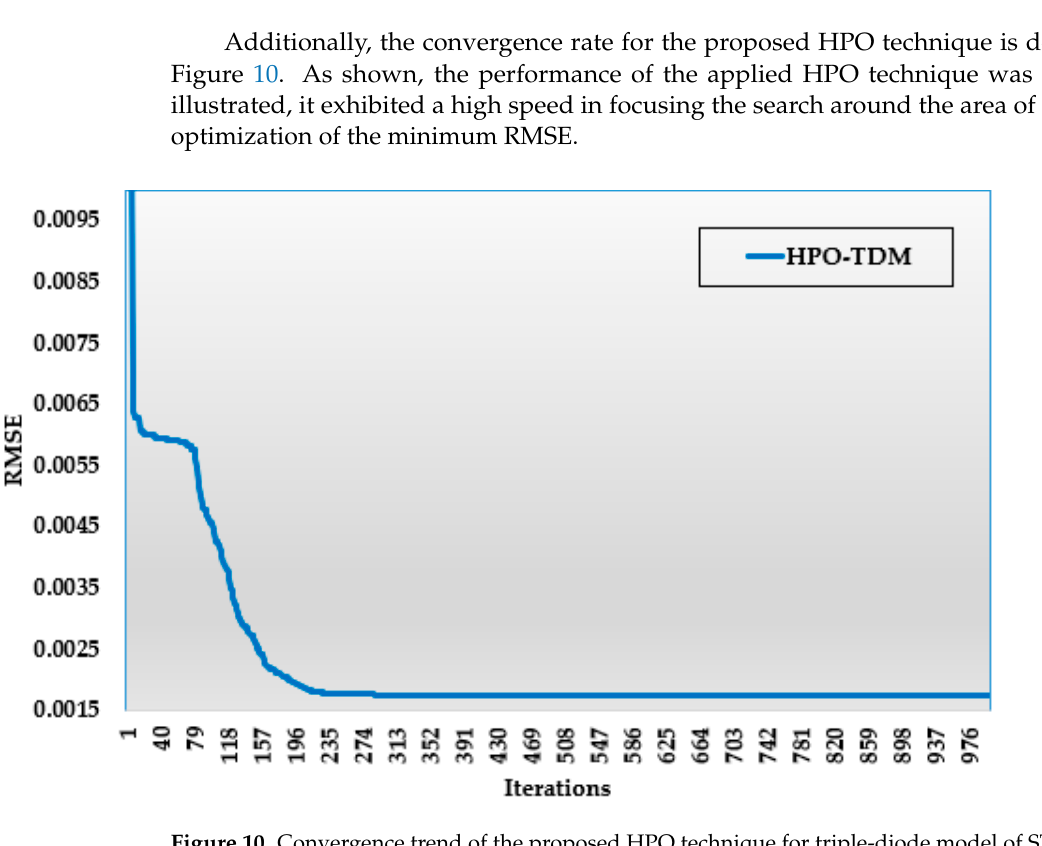
Table 7. Comparative assessment of the proposed HPO technique versus recently reported optimiz- ers for the triple-diode model with STM6_40/36 PV module.